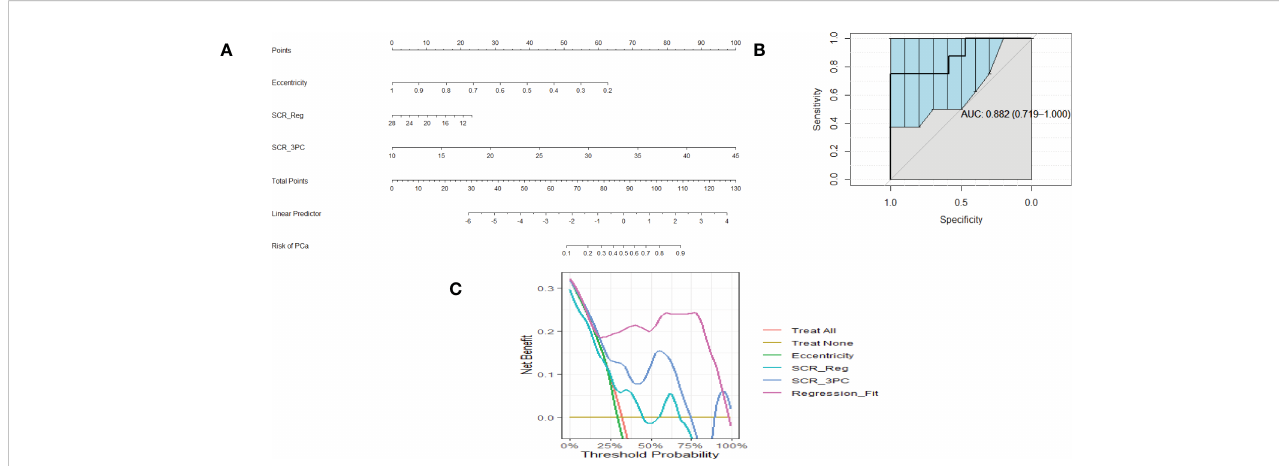
FIGURE 2 (A) is a nomogram resulting from logistic fi t to Gleason score with eccentricity, regularized SCR, and SCR with 3 PC removed. (B) . ROC curve for fi tting eccentricity, regularized SCR and SCR after 3 PC removed, Area Under the Curve (AUC) and 95% Con fi dence Limits shown as bold and lighter line with vertical bars (C) . Decision Curve Analysis for (A)